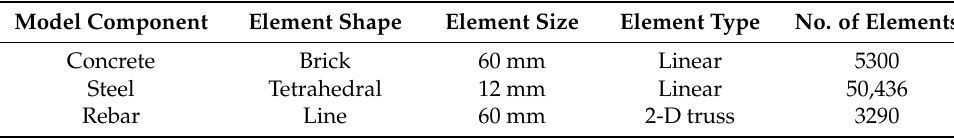
Table 8. Solution parameters.